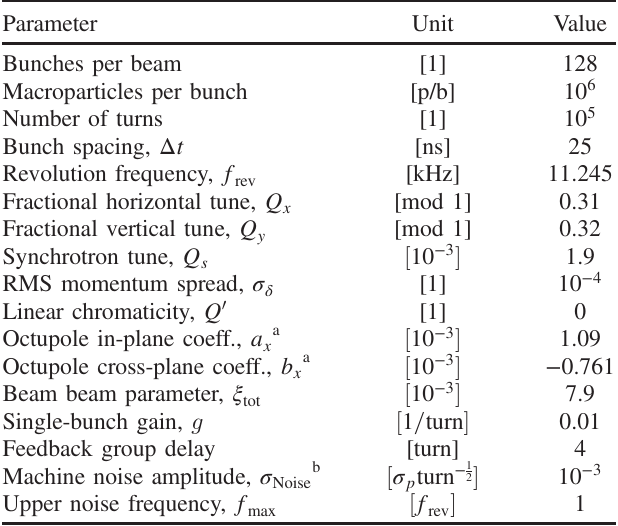
TABLE I. Numerical parameters used in the